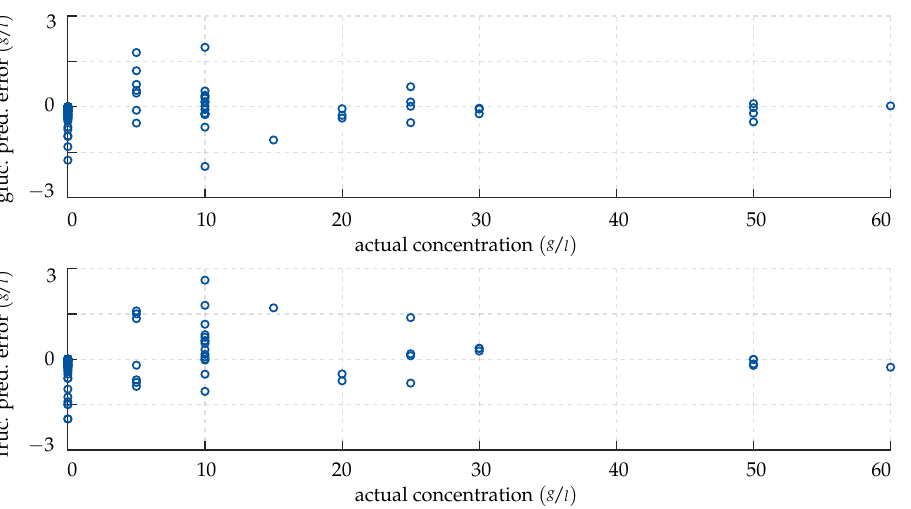
Figure 9. Prediction error made by the CFNN for the test data. ( Top panel ) deviation in the predicted glucose concentration plotted over the actual concentration. ( Bottom panel ) deviation in the predicted fructose concentration plotted over the actual